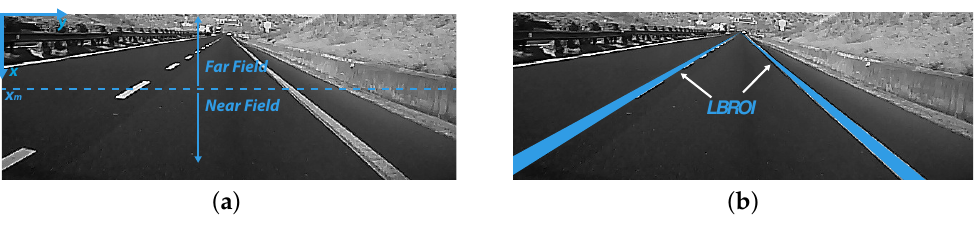
Figure 4. Lane-detection and tracking algorithm.